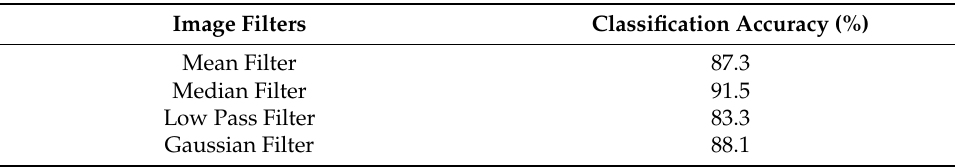
Table 1. Noise estimation through filters with